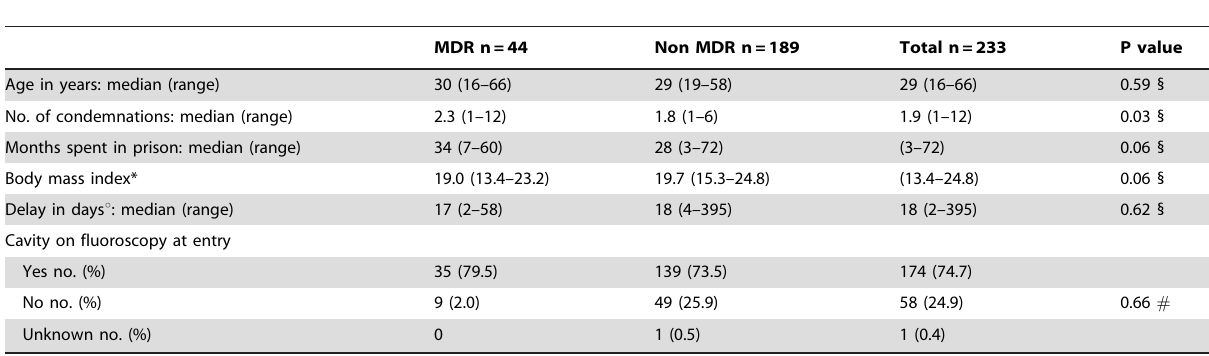
Table 2. Socio-demographic and clinical characteristics of patients at